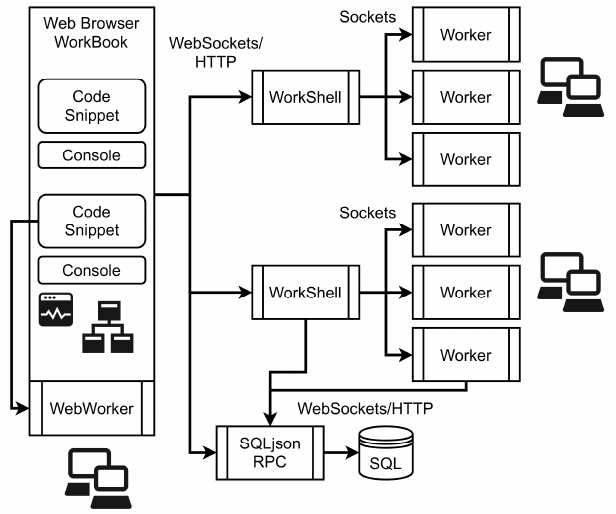
Figure 1 . Web browser-based software architecture with remote worker processes [1] Figure 1. Web browser-based software architecture with remote worker processes [1]. Both software frameworks use the same input data and functionally and structurally equivalent CNN